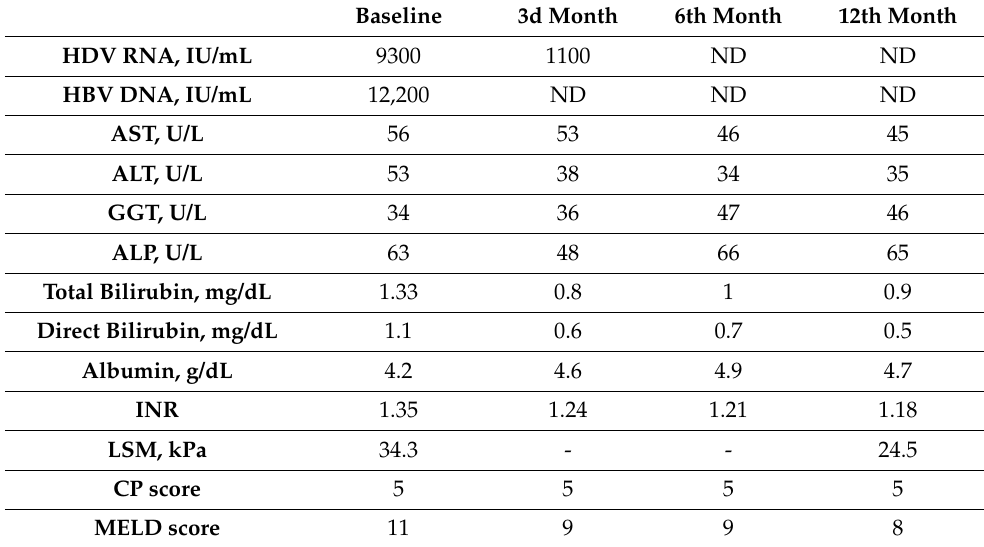
Table 1. Evaluation before and during